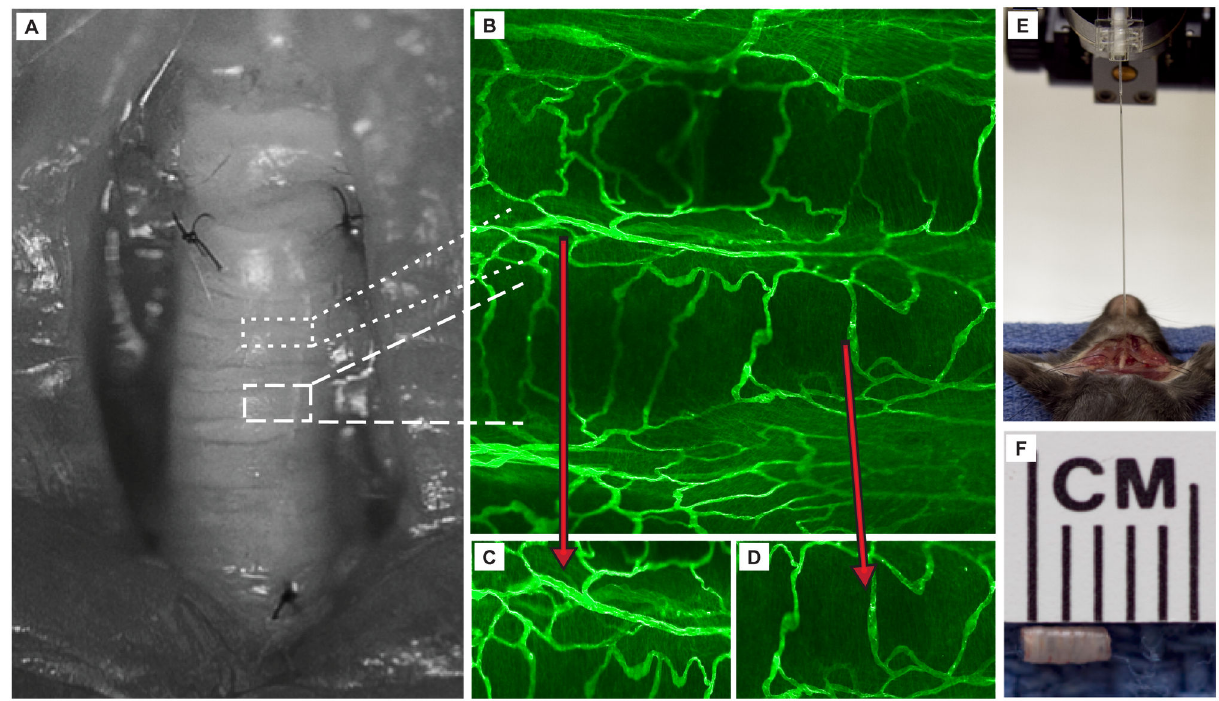
Figure 1. Orthotopic tracheal transplant: method of assessment for microvascular perfusion and tissue hypoxia. ( A ) The OTT involves the removal of a 7-ring donor segment (shown in panel F) and transplantation into an allogeneic animal (BALB/cB6) or syngeneic animal (B6B6) under the microscope. Two sutures (10-0 nylon) are placed in the cephalad anastomosis and 3 sutures secure the caudad anastomosis. ( B ) FITC-lectin perfusion profile of whole-mount tracheal grafts in un-transplanted control illustrates the linear display of blood vessels in 2-dimensions. ( C ) OTT vessels in the intra-membraneous tracheal portion. ( D ) OTT vessels in the cartilaginous portion of the tracheal segment. ( E ) Illustrative example of the method for measurement of perfusion, using a laser Doppler flowmetry probe, and tissue oxygen tension measurement using a microsensor tissue oxygenation probe. ( F ) Gross image of explanted tracheal segment, dimensions are approximately width, 1mm x length, 2.5